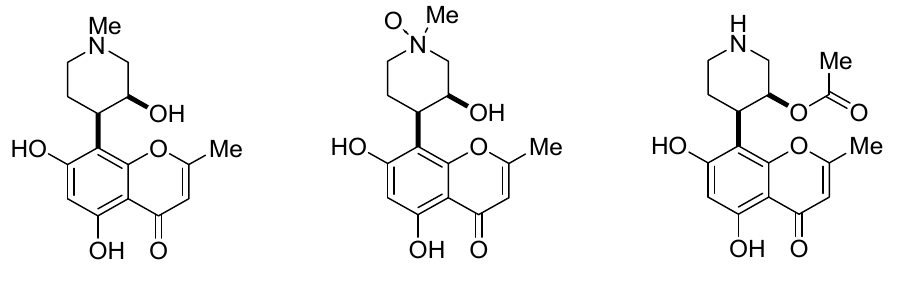
Figure 18. Rohitukine ( 45 ) and rohitukine derivatives ( 46 and 47 ).